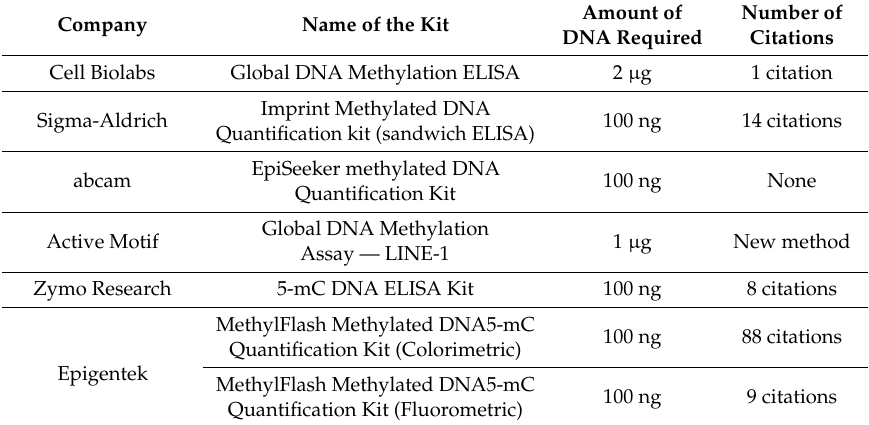
Table 1. ELISA-based kits for global DNA methylation